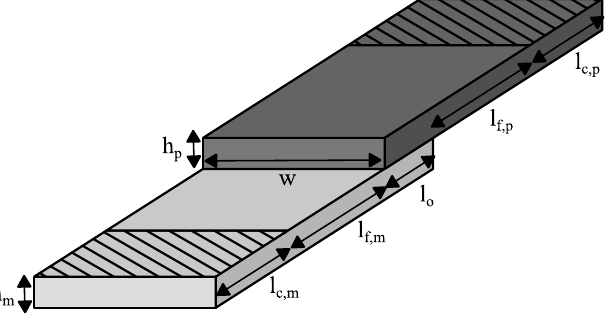
Figure 1. Lap shear specimen geometry.